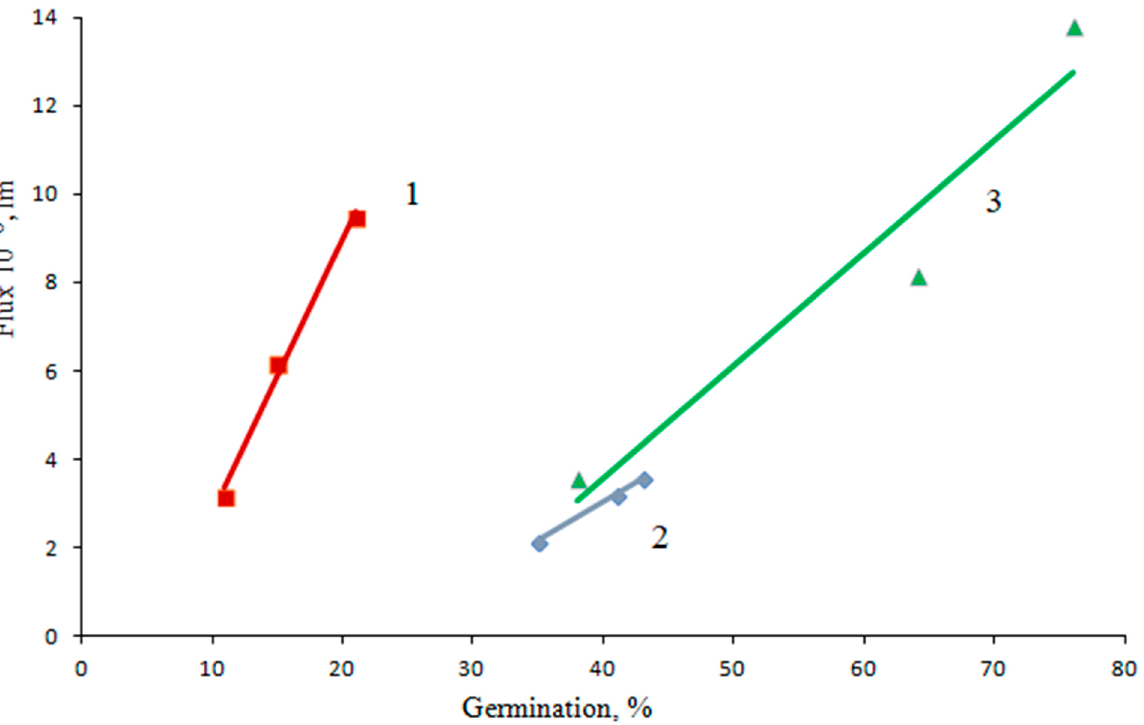
Figure 2. Approximation of the dependence of photoluminescence flux on the germination of